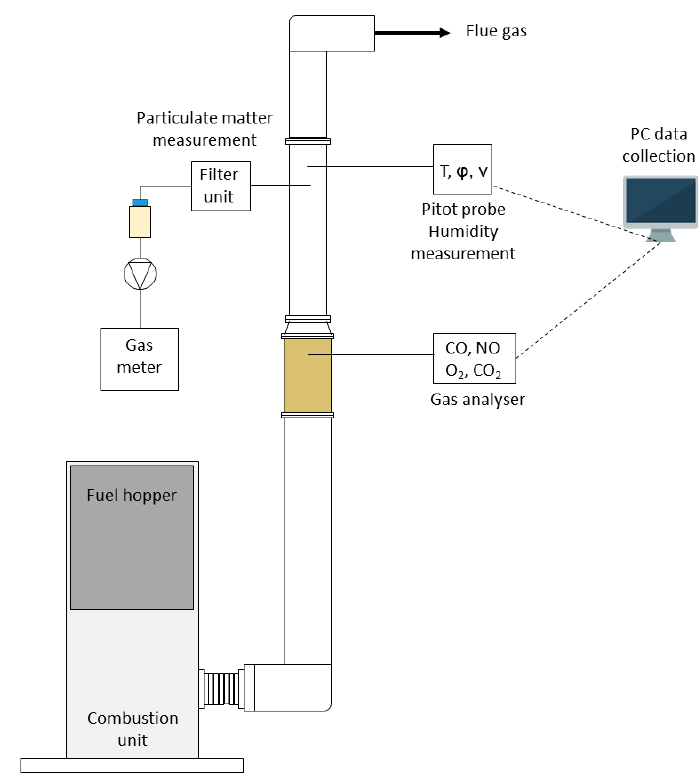
Figure 2. Schematic of the test stand.